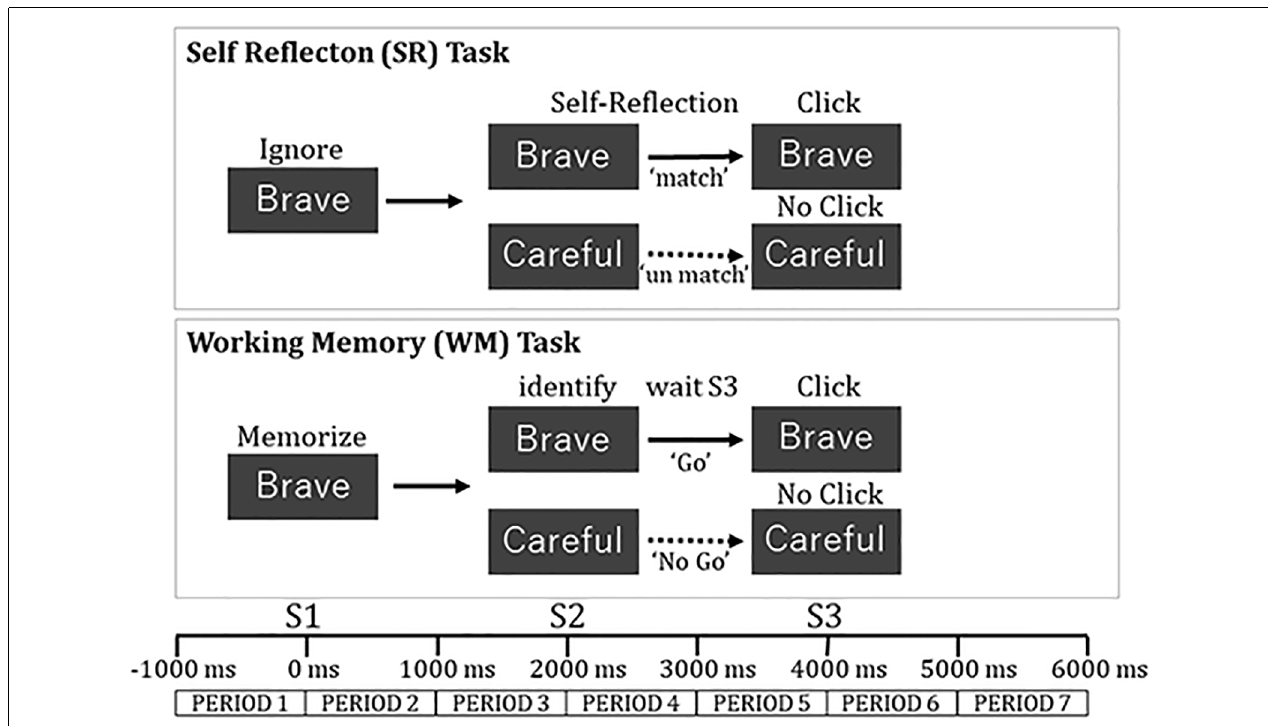
FIGURE 2 | Task procedure in each trial for self-reflection task and working memory